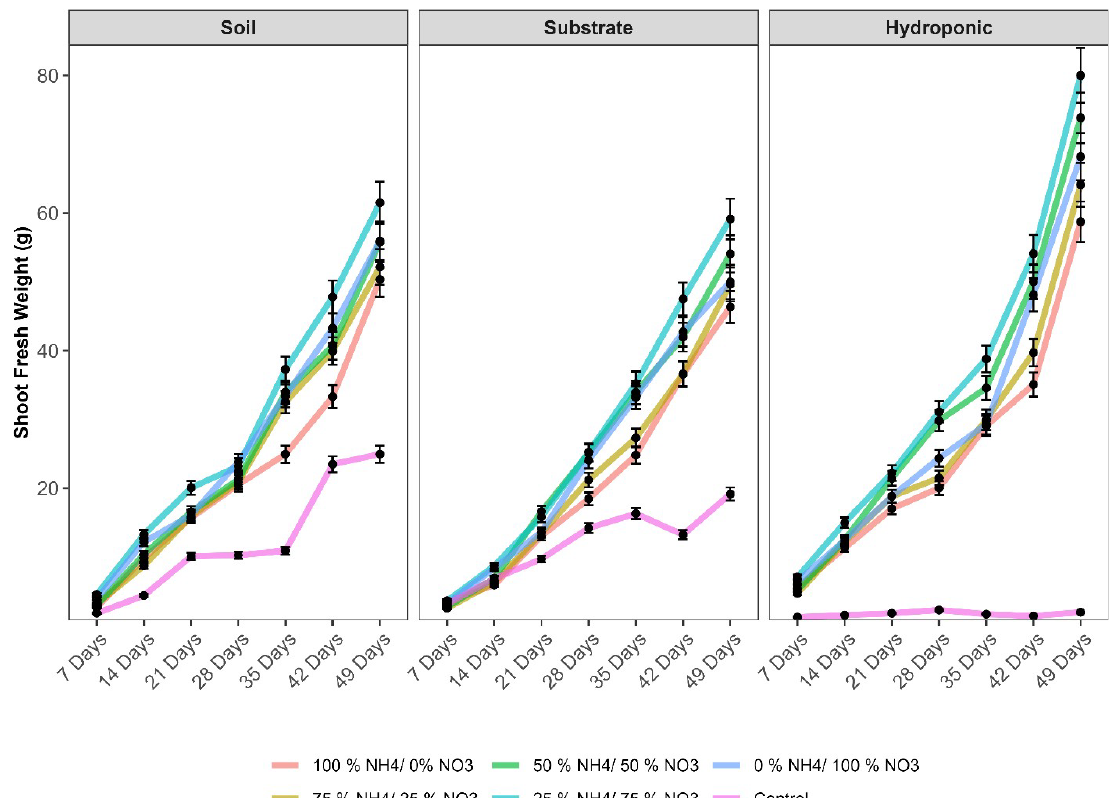
Figure 2. Effect of various applied NH 4+ /NO 3 − ratios (100:0, 75:25, 50:50, 25:75 and 0:100%) and control (no additional N applied) in different intervals of time on shoot fresh biomass of lettuce grown in soil, substrate and hydroponic cultivation systems. Note-The means ( n = 4) ± standard errors are shown in the data.